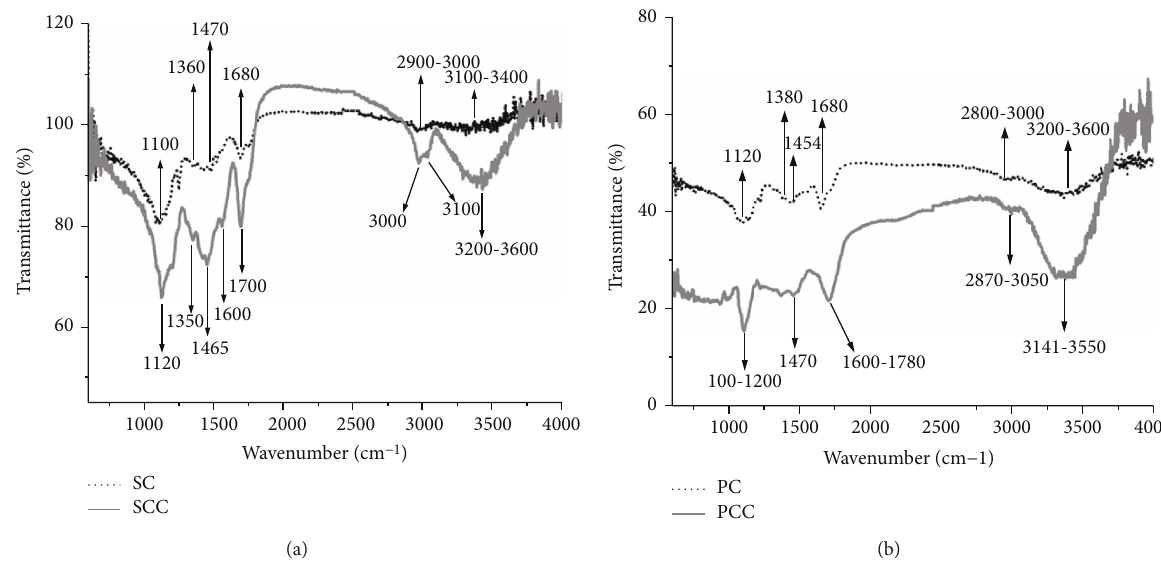
Figure 1: Comparative FTIR spectra of (a) simple chitosan (SC) and simple chitosan composite (SCC) membranes; (b) porous chitosan (PC) and porous chitosan composite (PCC)